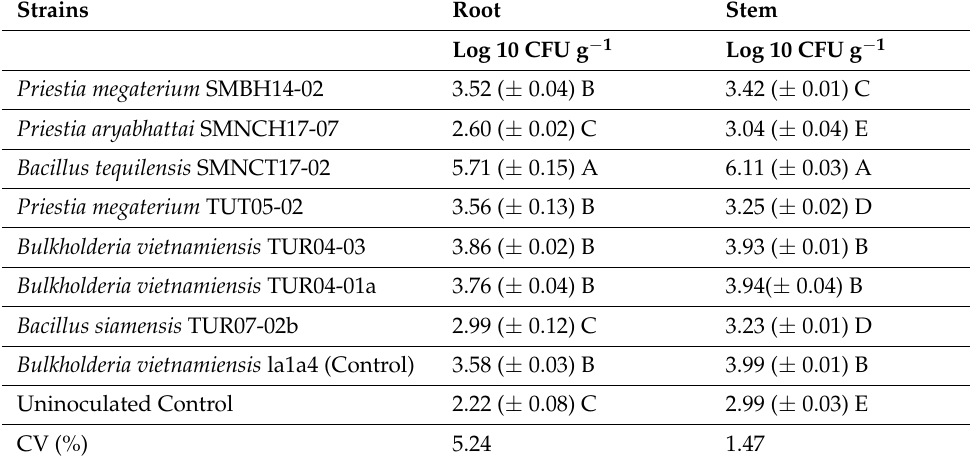
Figure 1. Neighbor-joining phylogenetic tree based on 16S rDNA gene sequences (1300 positions) showing the relationships among endophytes Priestia species isolated from rice in Northern Peru and closely related species of the genus Priestia . A bootstrap value indicates the significance of each branch (as percentage) calculated for 1000 subsets (only values greater than 50% are indicated). Bar, two substitutions per 100 nucleotide positions. The 16S rDNA sequence of Bradyrhizobium paxllaeri LMTR-21 T was used as an outgroup. Table 1. Log number of endophytic bacteria (CFU g − 1 ) colonizing the root and stem tissue of Oryza sativa var. “Bellavista” growing for 7 days under gnotobiotic